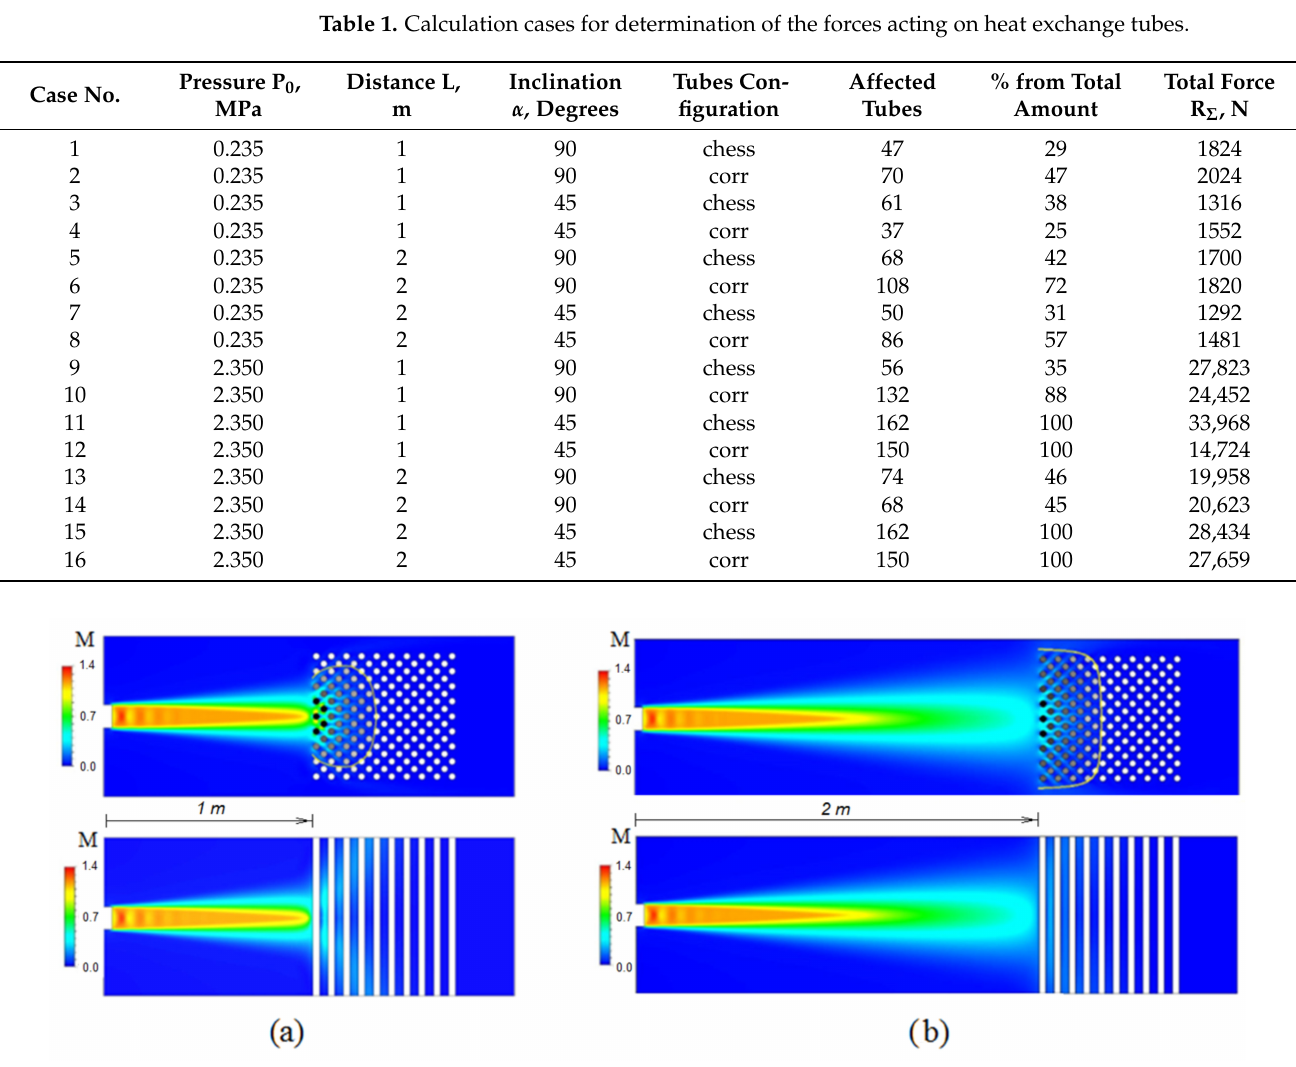
Figure 4. Blowing of the tube package by an air jet with pressure P 0 = 0.235 MPa. ( a ) Case 1; and ( b ) case 5. Upper—XOY plane, lower—XOZ plane.